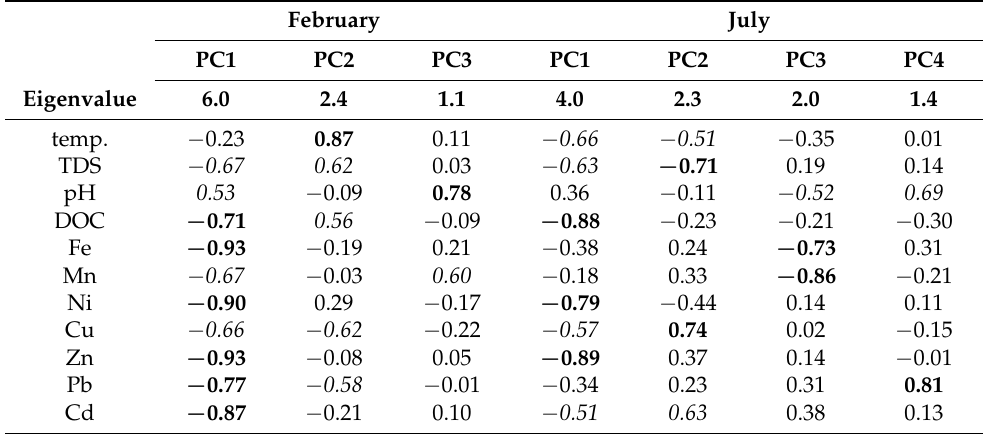
Table 5. Eigenvalues and coefficients of correlation between variables and components calculated for datasets obtained for February and July (in